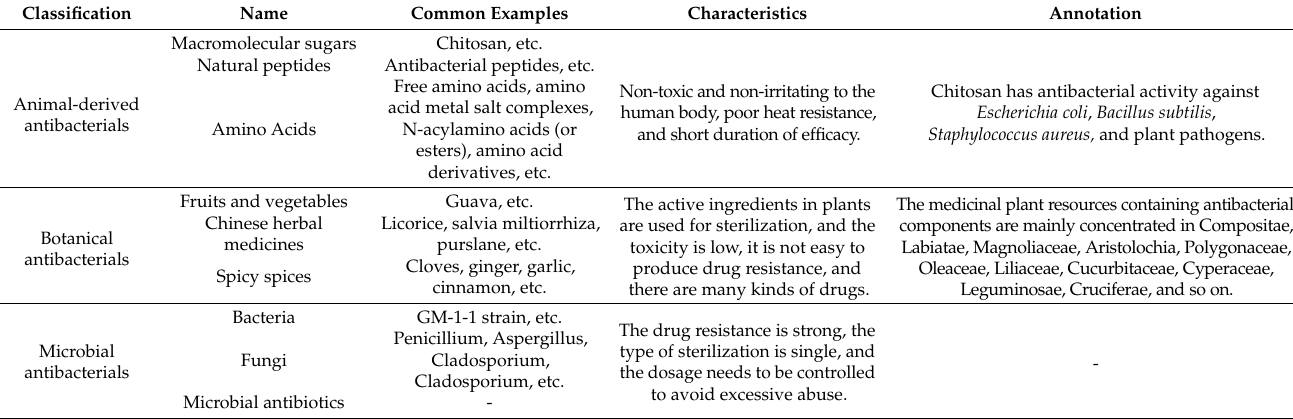
Table 2. Classification of natural antibacterials